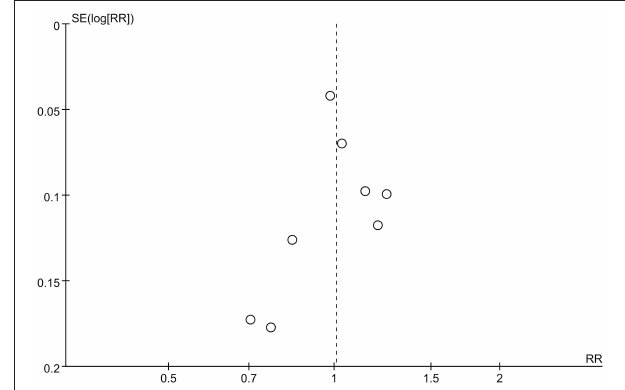
FIGURE 3 | Funnel plot of standard errors against logarithms of odds ratios for studies comparing long-term success rates of PVI between Group A ( + ) and Group A ( − ).